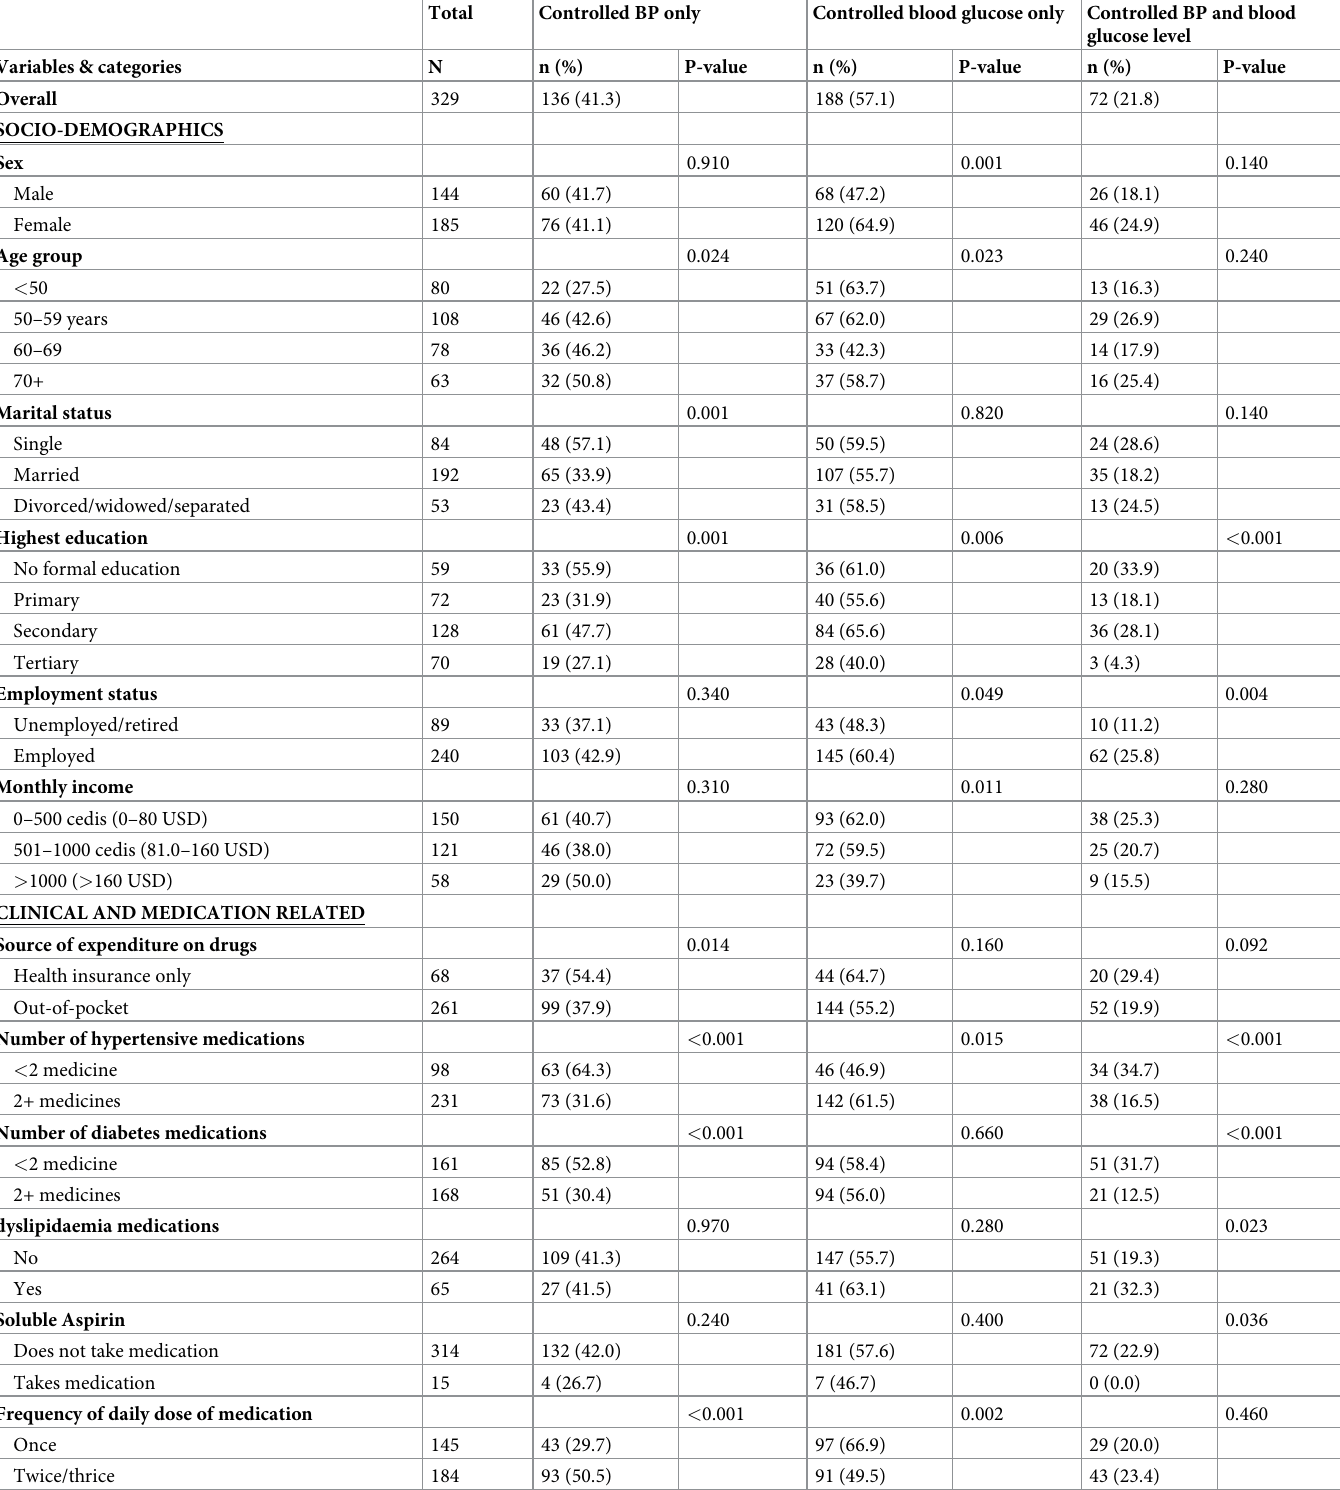
Table 3. Bivariate analysis of factors associated with blood pressure level and blood glucose level among hypertensive and type-2 diabetes mellitus co-morbid